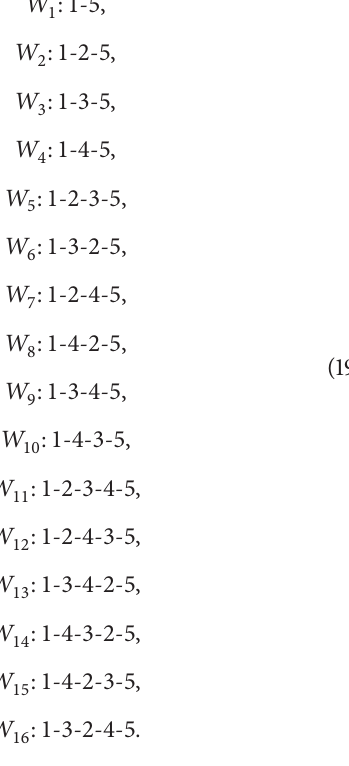
Table 3: The total time taken and total collected score values for each of the paths. Path Total time taken to traverse Total collected score